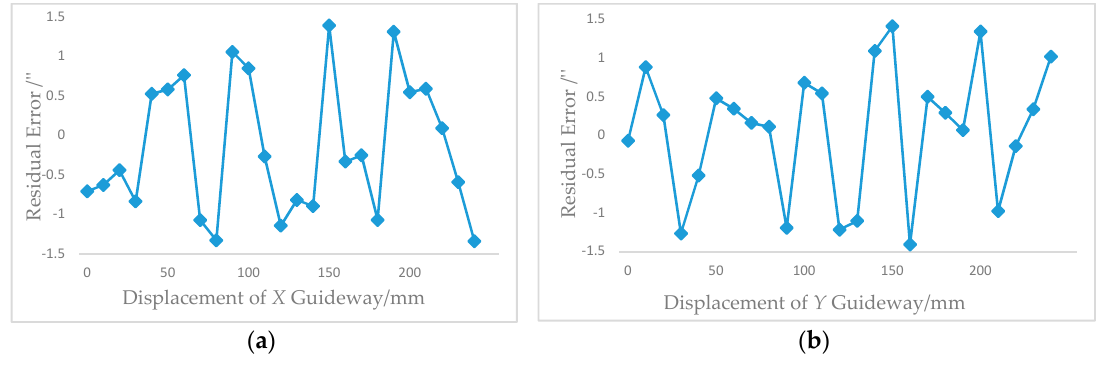
Figure 11. Residual errors of the proposed system: ( a ) Residual error of ε y ( x ); ( b ) Residual error of ε x ( y ).